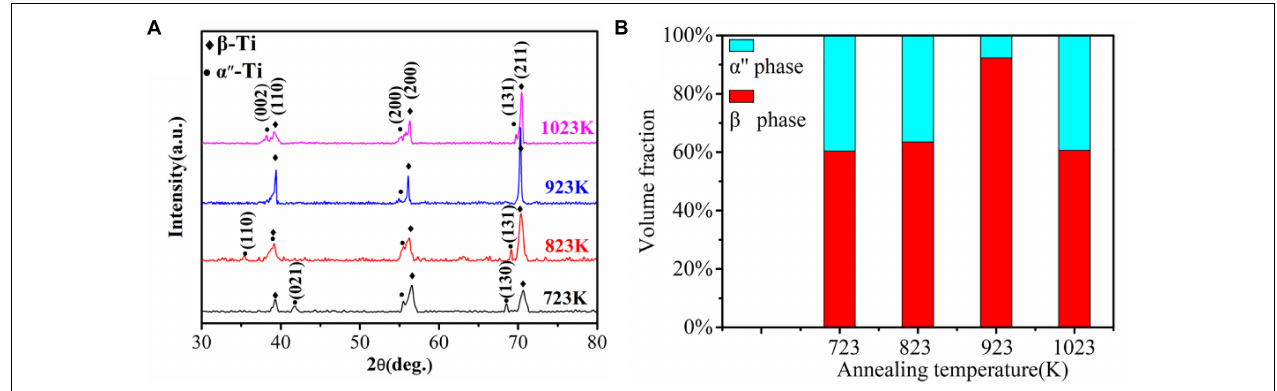
FIGURE 2 | (A) XRD patterns of Ti-35Nb-2Ta-3Zr annealed specimens: 723, 823, 923, and 1023 K; (B) volume fraction (V f ) of α (cid:48)(cid:48) and β phase after annealing at different temperatures.